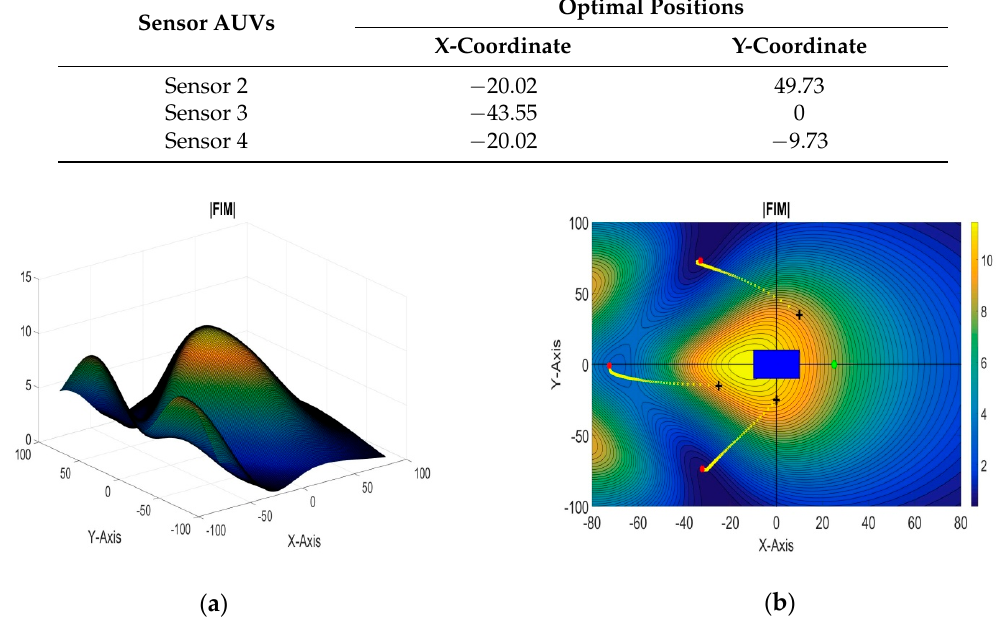
Table 5. Optimal Positions of Sensor AUVs (with Uncertain Target Position).